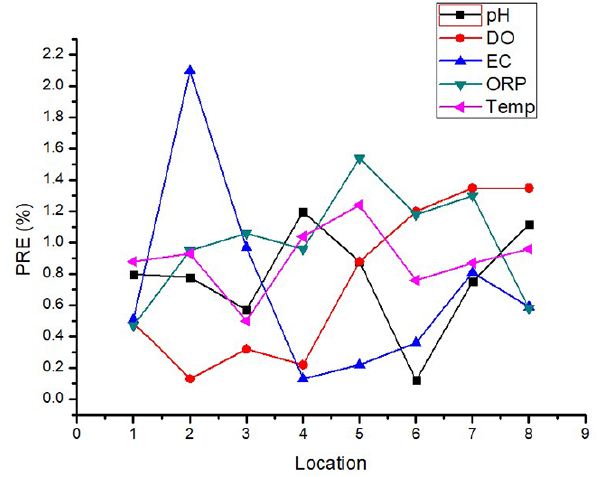
Figure 5. Percentage relative error (PRE) plot for different water quality